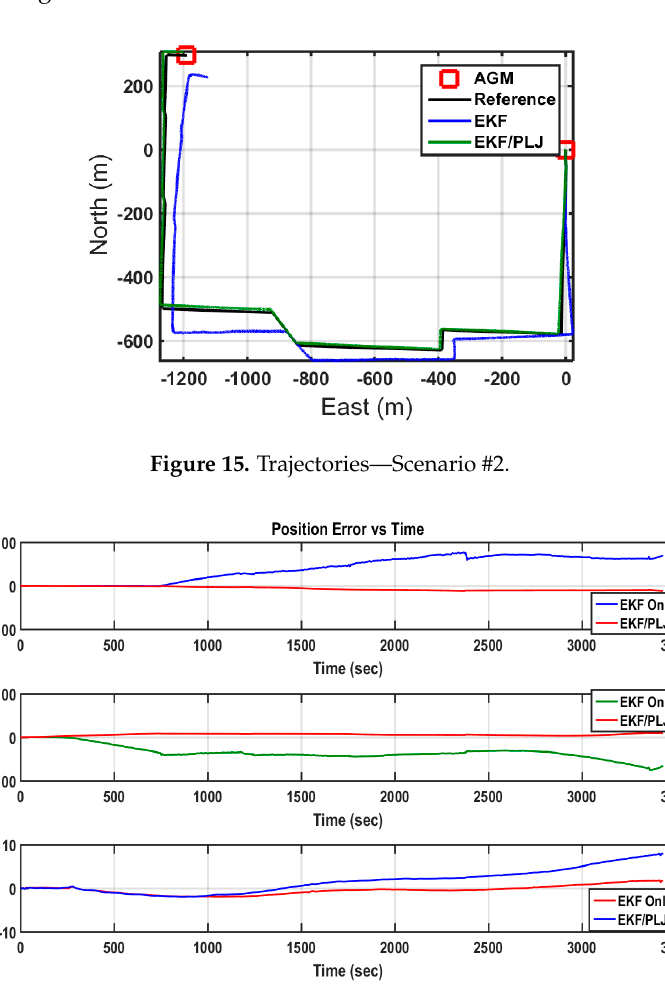
Figure 16. Positions Errors—EKF & EKF/PLJ Scenario #2.